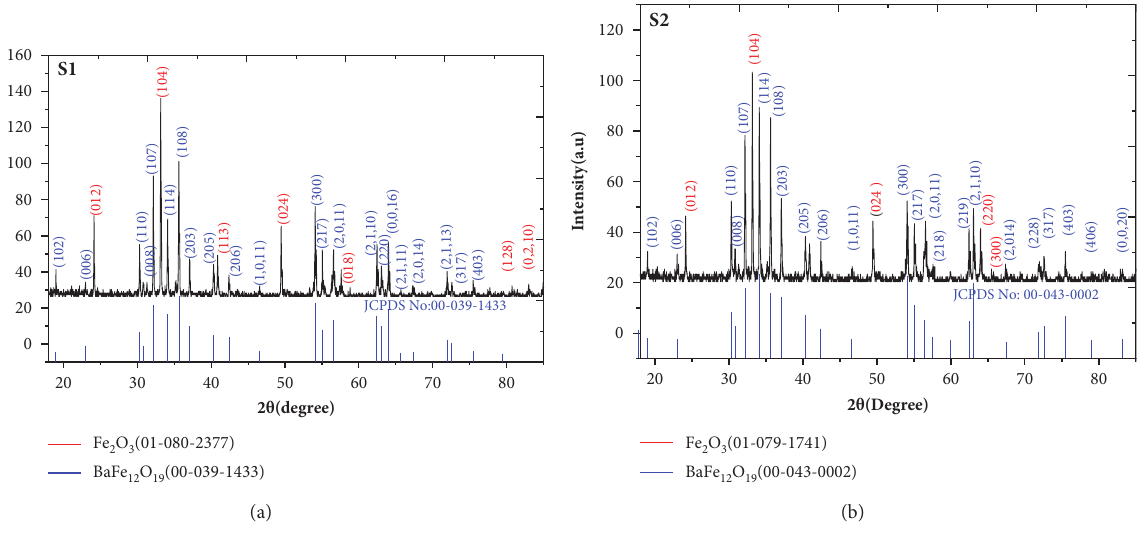
Figure 1: XRD patterns of (a and b).